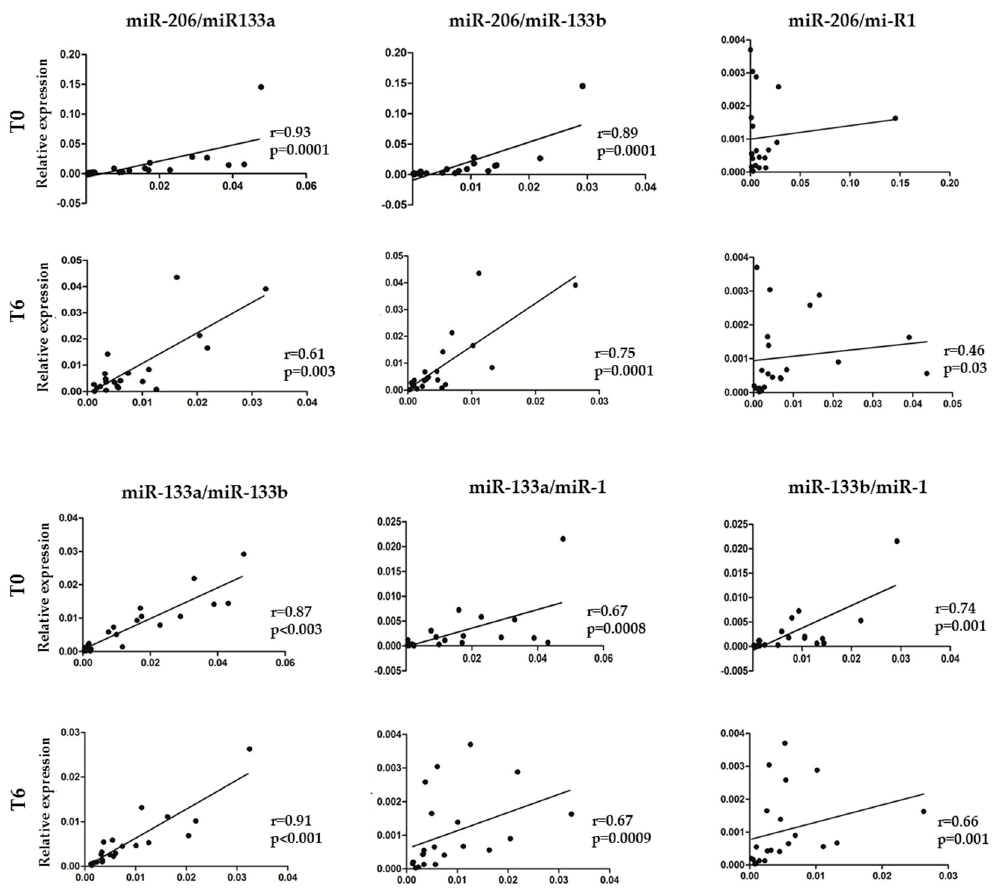
Figure 2. Spearman’s correlations between each myomiR expression in SMA patients during nusinersen treatment. Spearman’s correlation coe ffi cients (r) were used to corroborate relationships between myomiR expression levels in serum of SMA patients at baseline (T0) and 6 months after treatment (T6). Coe ffi cients major than 0.5 indicate a good positive correlation. p values ( p < 0.05) and r (r ≥ 0.046) coe ffi cients were assessed by Spearman test.